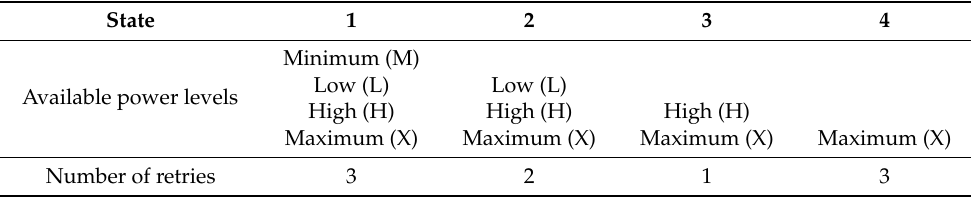
Table 1. States, power levels and retry limits.